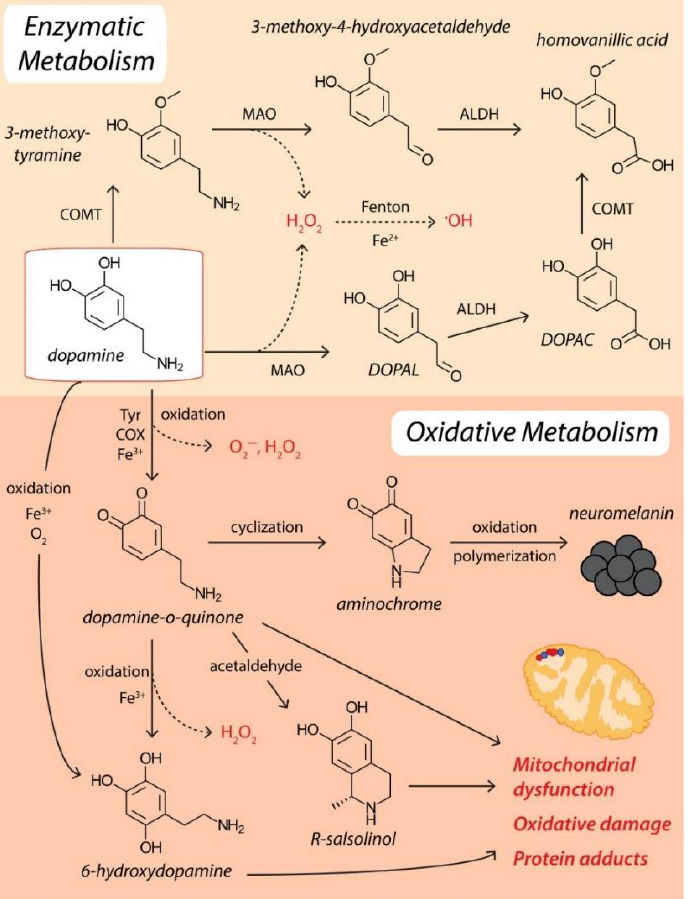
Figure 2. Dopamine metabolism and ROS production. Reprinted from an open-access source [21].